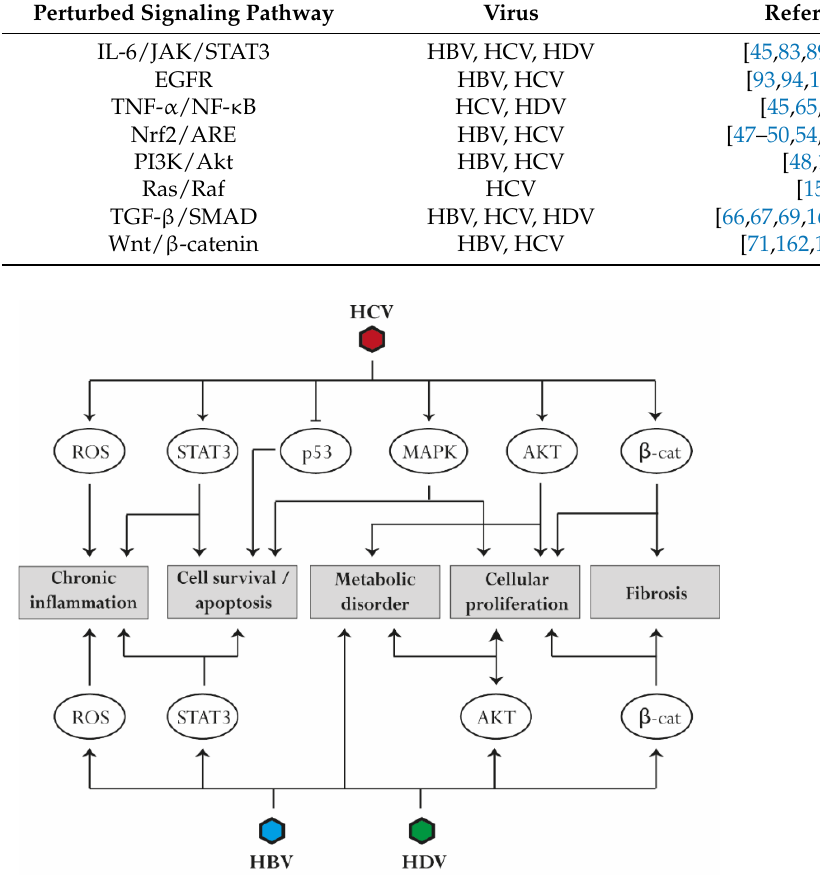
Figure 2. Common pathways associated with virus-induced liver disease progression. Several perturbations are mediated by HBV, HCV, and HDV infection. Reactive oxygen species (ROS) production and activation of STAT3 contribute to the establishment of chronic liver inflammation. Upregulation of mitogen-activated protein kinase (MAPK) and STAT3 signaling as well as downregulation of p53 reduce apoptosis and promote cell survival. Similarly, activation of AKT, MAPK, and β -catenin induces cell proliferation. AKT upregulation contributes to the development of metabolic disorders, while β -catenin is involved in the progression of liver